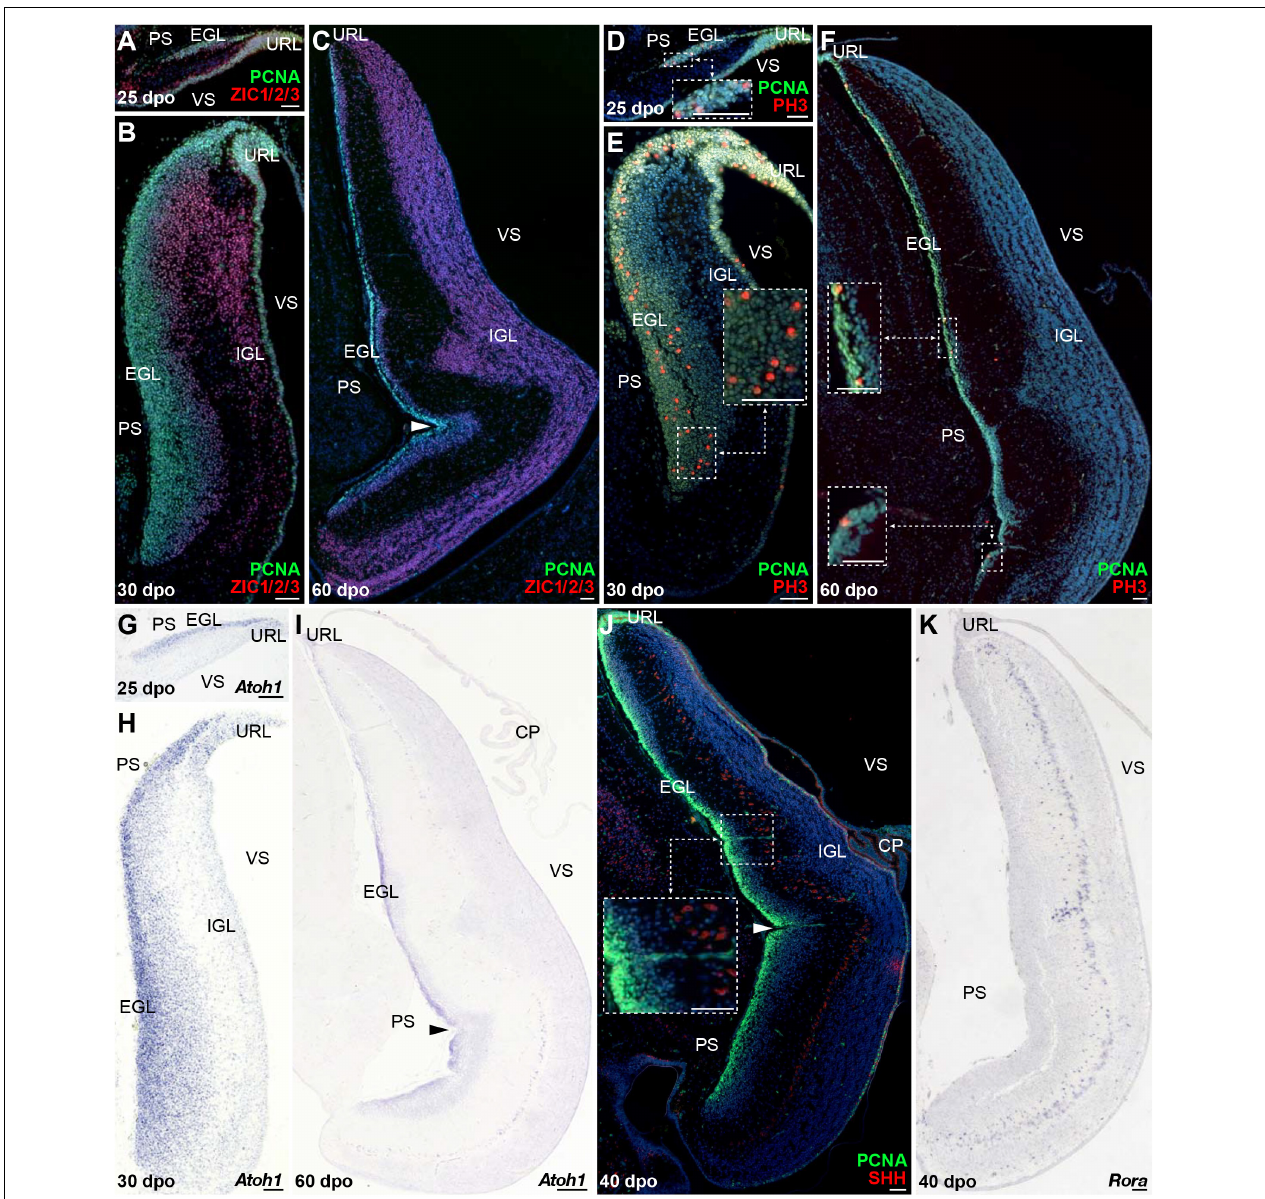
FIGURE 3 | Molecular characterization of GC patterning in P. vitticeps . (A–F) Double IHC for PCNA (green staining) with ZIC1/2/3 [ (A–C) ; red] or PH3 [ (D–F) ; red] markers at various indicated embryonic developmental stages (25, 30, and 60 dpo) in the cerebellum of P. vitticeps . Insets in panels (D–F) show high magnifications of mitotic progenitors on the pial surface. (G–I) In situ hybridization (ISH) showing the expression of Atoh1 at various indicated embryonic developmental stages (25, 30, and 60 dpo). (J,K) Double IHC for PCNA (green) and SHH [ (J) ; red] or ISH for Rora (K) at 40 dpo. The inset in panel (J) shows high magnification of SHH-positive PCs. Arrowheads in (C,I,J) indicate the position of the incomplete fissure on the cerebellar pial surface. PS, pial surface; EGL, external granule layer; IGL, internal granule layer; VS, ventricular surface; URL, upper rhombic lip; CP, choroid plexus. Scale bars: 50 µ